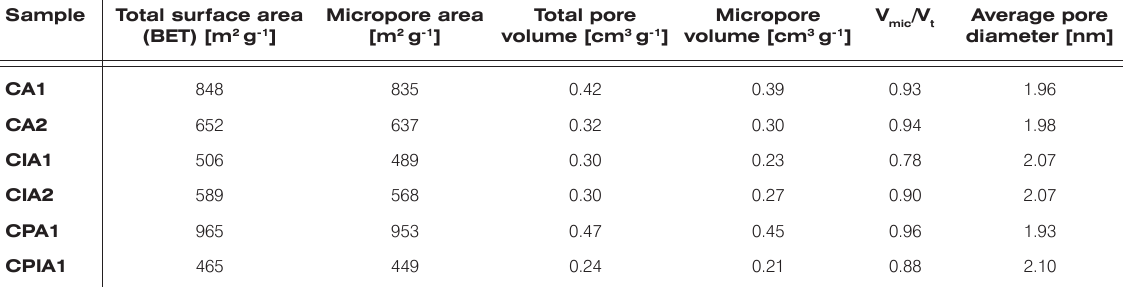
Table 3. Textural parameters of the activated samples obtained.